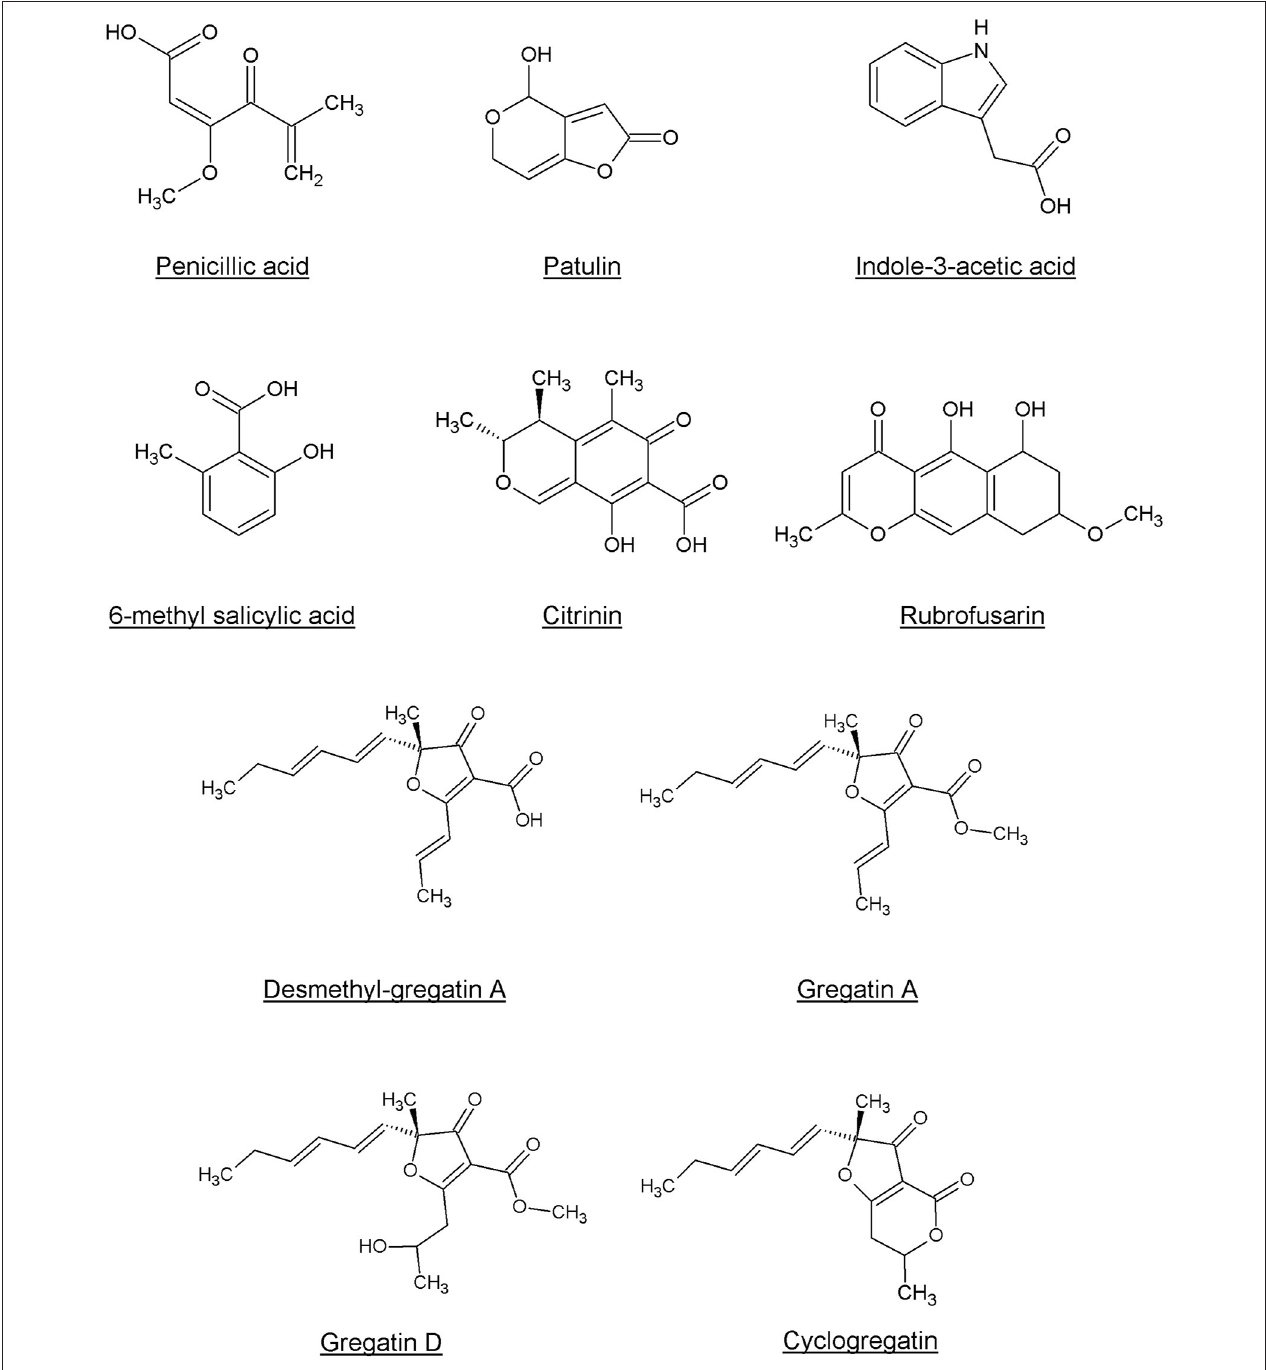
FIGURE 4 | Chemical structures of the compounds identified as QS inhibitors in this